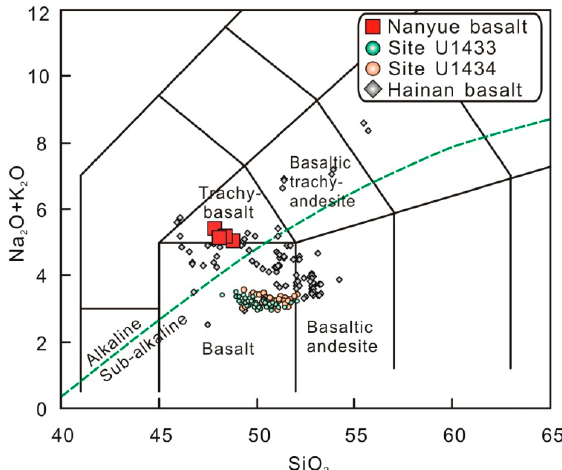
Figure 3. SiO 2 vs. total alkalis (Na 2 O + K 2 O) diagram of [26]. The alkaline–subalkaline boundary is after [27]. Compositional data for volcanic rocks from the Hainan Island and the IODP Sites U1433 and U1434 are from [5] and [13].